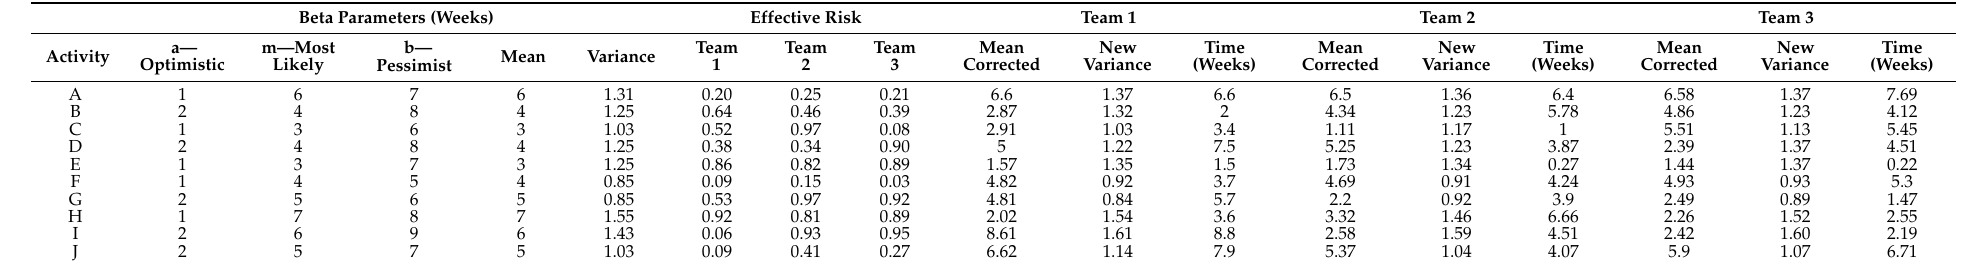
Table 9. Effective risk results for every team, every project task, and Monte Carlo